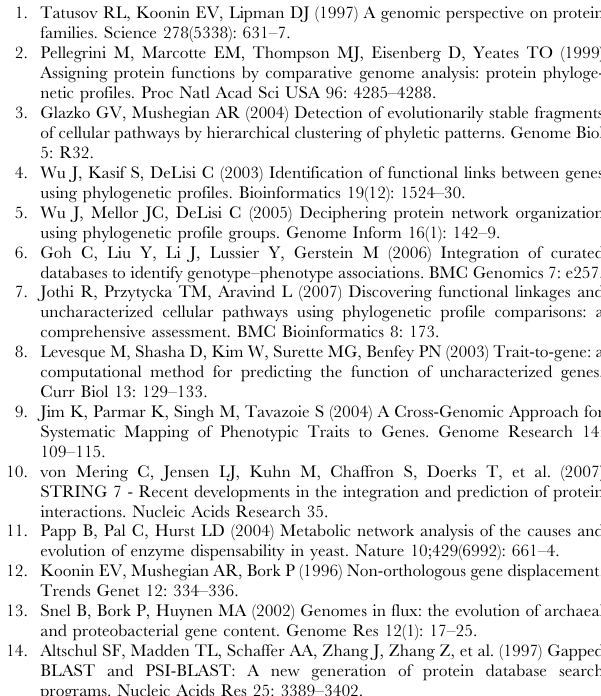
Table S5 Psi-square search results for food poisoning phenotype.